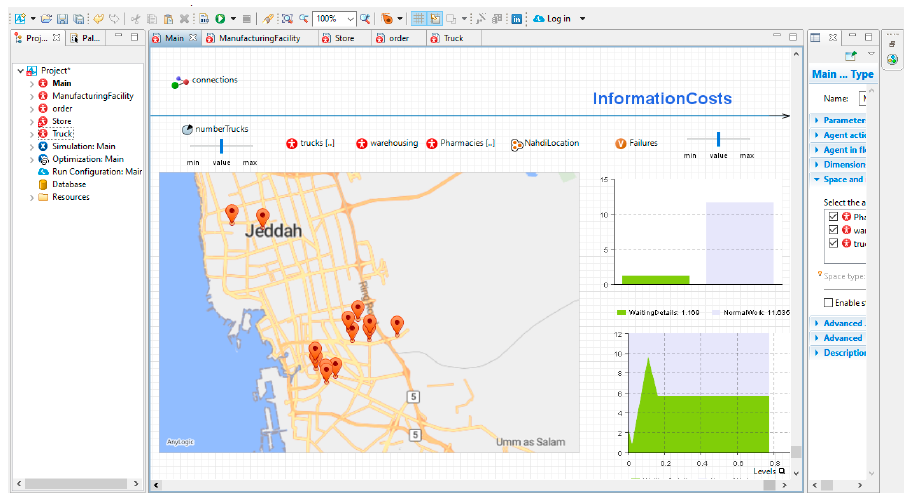
Figure 7. The main level in ABSM.